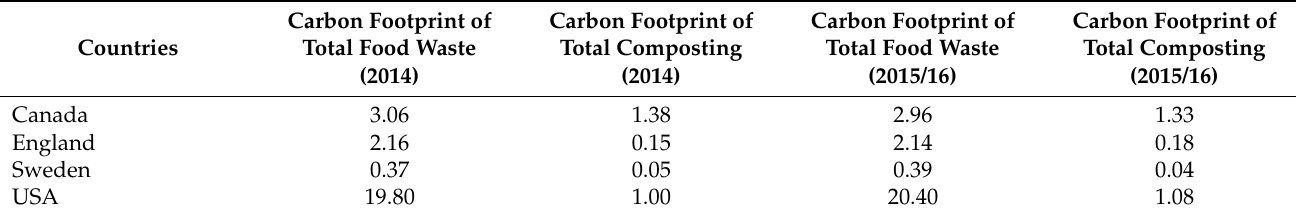
Table 2. Carbon footprint calculation using CCaLC2 (Mega Tonnes CO 2